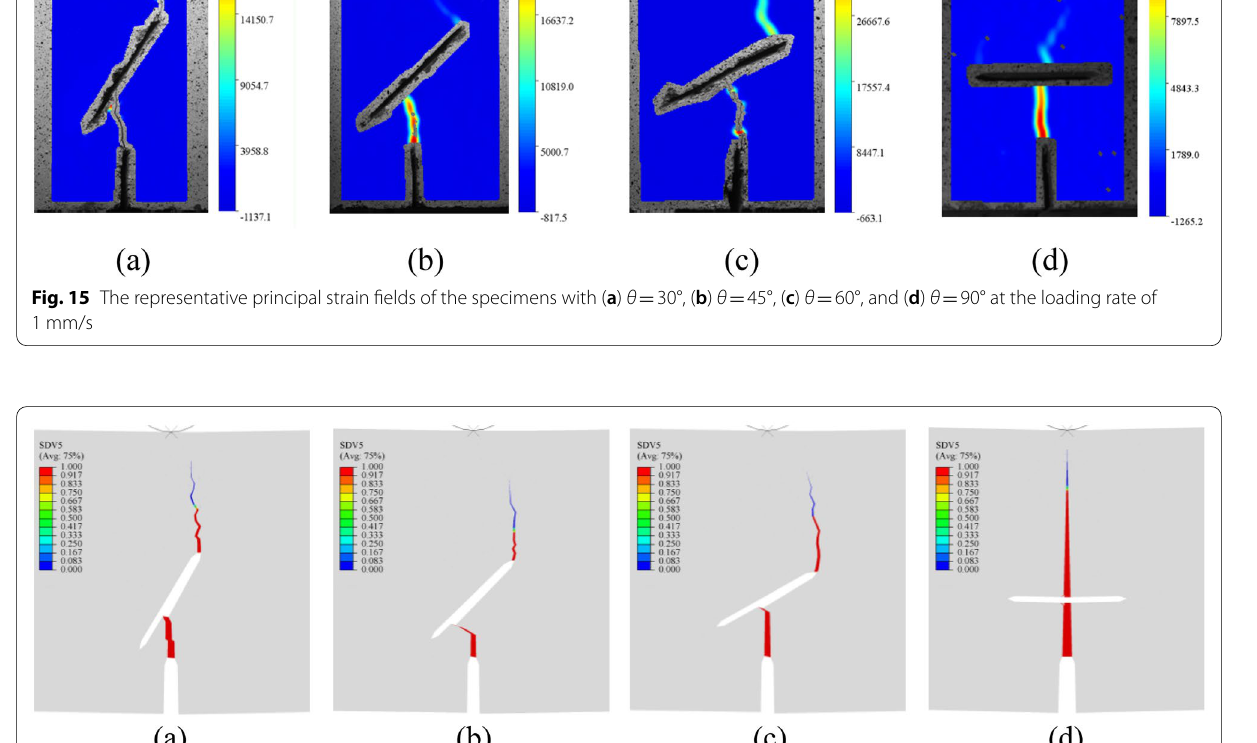
30°, ( b ) θ 45°, ( c ) θ 60°, and ( d ) θ 90° at the loading rate of 1 = = = =